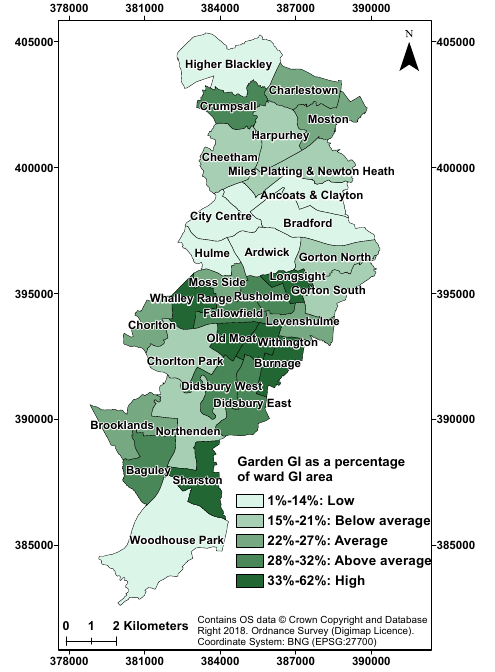
Figure 9. Garden green infrastructure (GI) as a percentage of ward GI area (classified by